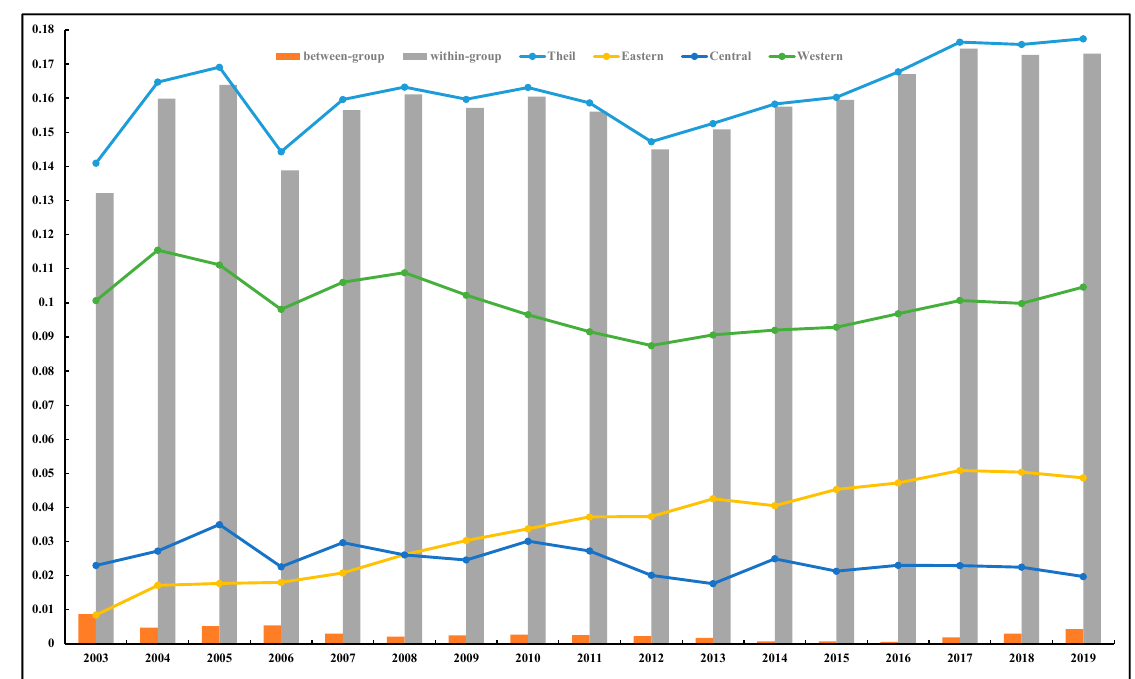
Figure 6. Regional differences of the output intensity of agricultural water.